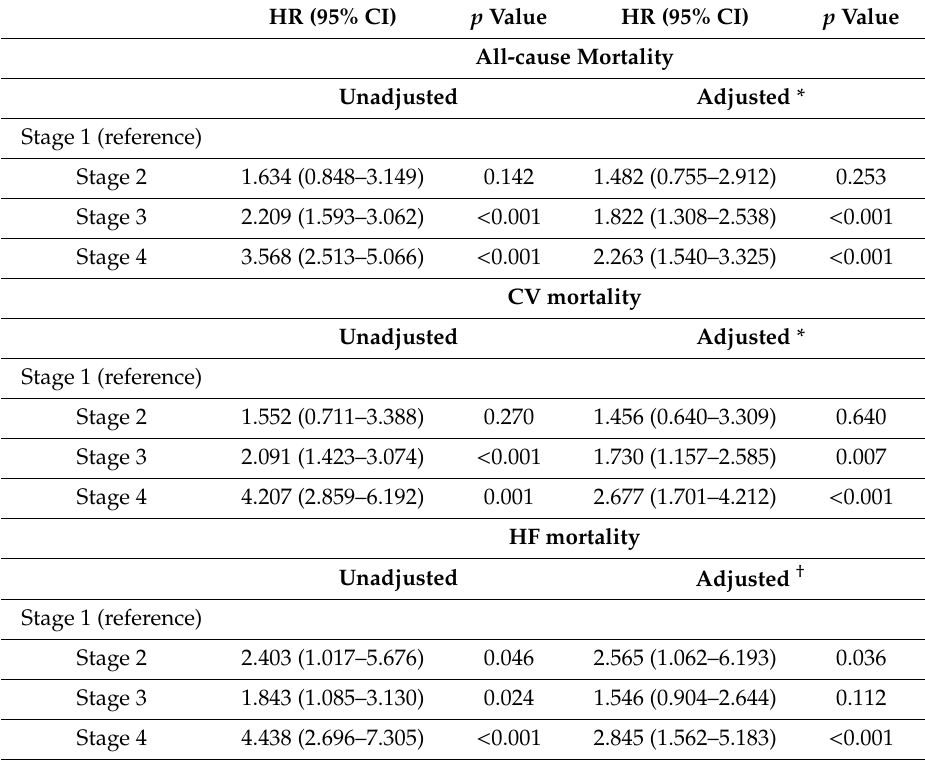
Table 2. Univariable and multivariable estimates of risk of the proposed right ventricular dysfunction (RVD) stages in the Cox regression analyses for all-cause, cardiovascular (CV), and heart failure (HF)-related